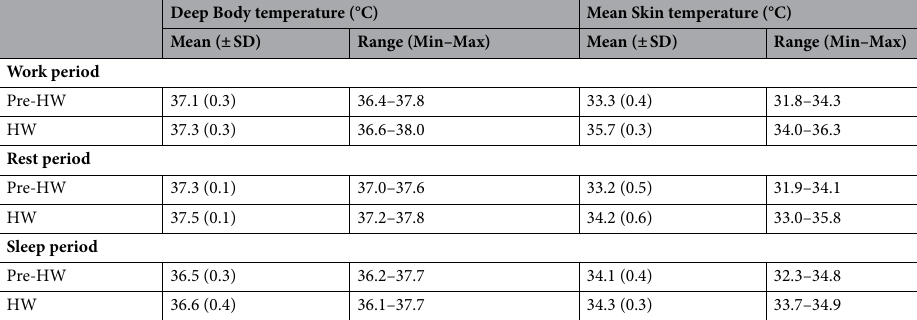
Table 1. Measured mean (± SD) and range of deep body and skin temperatures over the 24-h period during work, rest, and sleep periods. Temperature is presented as a mean of both 3-day non-HW and HW conditions. Work period: 09.00–18.00. Rest period: 18.00–23.00. Sleep period: 23.00–07.00. Pre-HW: Average of testing days 1–3. HW: Average of testing days 4–6. Ambient